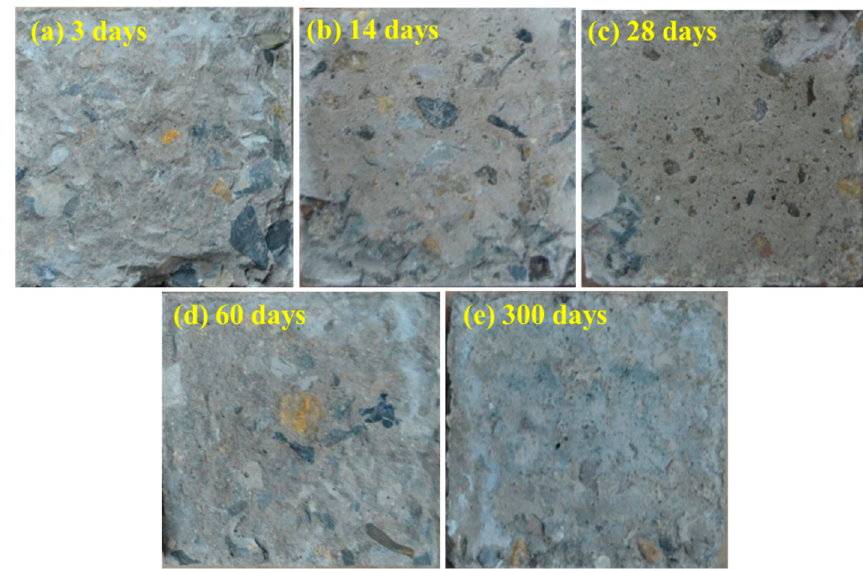
Figure 3. The bonding surface for specimens in group B after splitting tensile tests: ( a ) at 3 days, ( b ) at 14 days, ( c ) at 28 days, ( d ) at 60 days, ( e ) at 300 days.